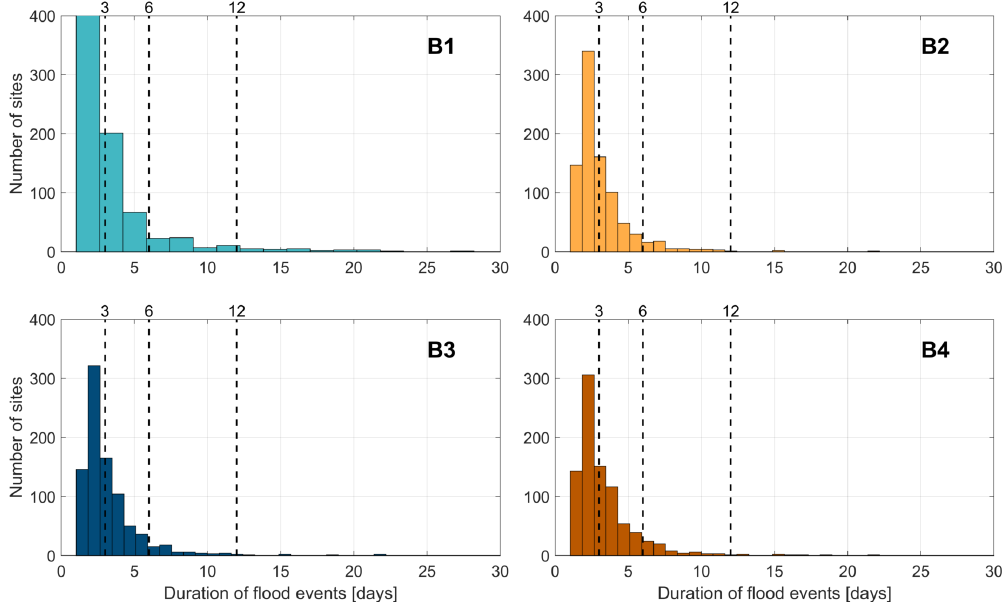
Figure 7. Median values of duration of the flood events extracted by a threshold of the 99.5th percentile for each group of basins (B1–B4). The dashed lines represent the revisit time related to the three configurations of Sentinel-1: 3, 6 and